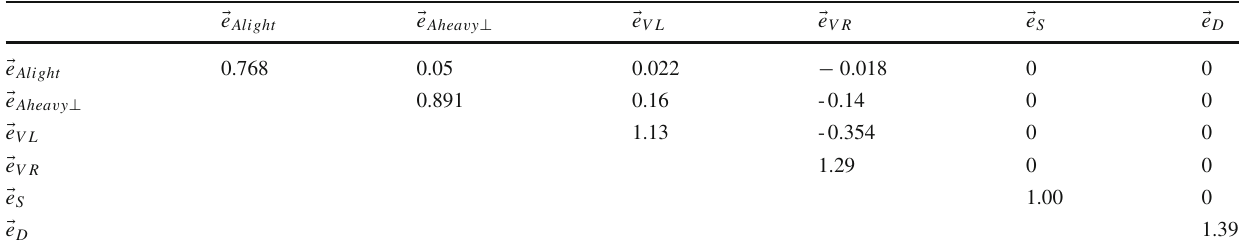
Table 5 Inner products between the basis vectors (cid:7) e i ((cid:4) LFV ∼ m W ) = G ∗ ( m W , m μ ) ˆ e i . On the diagonal are the norms (at m W in SMEFT, for unit-normalised ˆ e i at low energy), whereas the off-diagonals are cos η ,